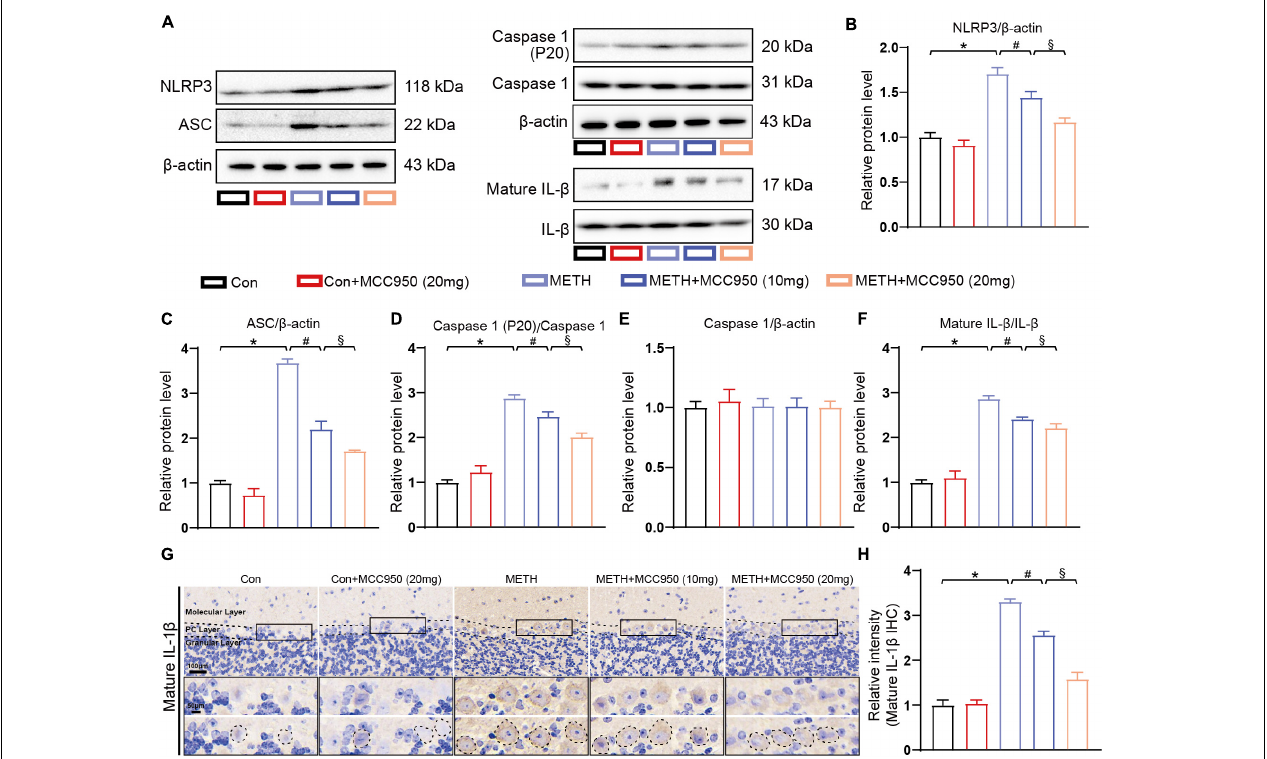
FIGURE 6 | Effect of MCC950 on NLRP3 pathway in METH mice model. (A) Representative western blot bands of NLRP3, ASC, Caspase-1, Cleaved Caspase-1, mature IL-1 β , and IL-1 β of mice cerebellar tissues in each group. (B–F) Quantification of NLRP3, ASC, Caspase-1, Cleaved Caspase-1, mature IL-1 β , and IL-1 β protein levels of mice cerebellar tissues from western blot bands. n = 3 per group. (G) Representative images of mature IL-1 β IHC staining in cerebellar areas. (H) Relative intensity of mature IL-1 β in cerebellar areas. One-way ANOVA and Bonferroni’s post-hoc analysis, * p < 0.05, compared with the Con group; # p < 0.05, compared with the METH-treated group; § p < 0.05, compared with the METH + MCC950 (10 mg)